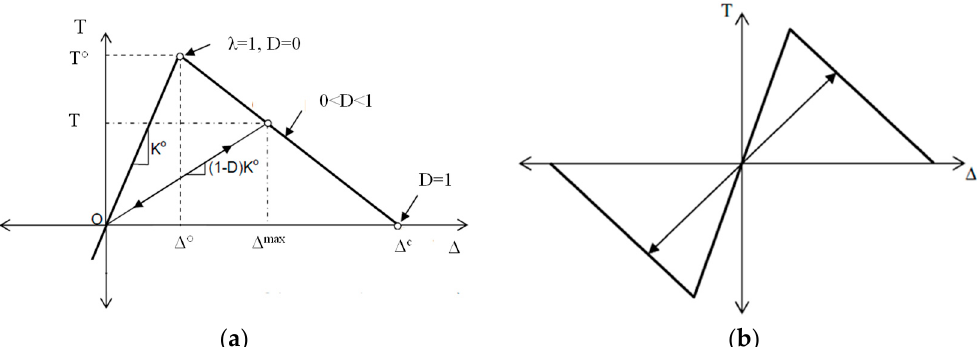
Figure 1. Schematic depiction of typical bilinear traction–separation law. ( a ) normal component, ( b ) tangential component.